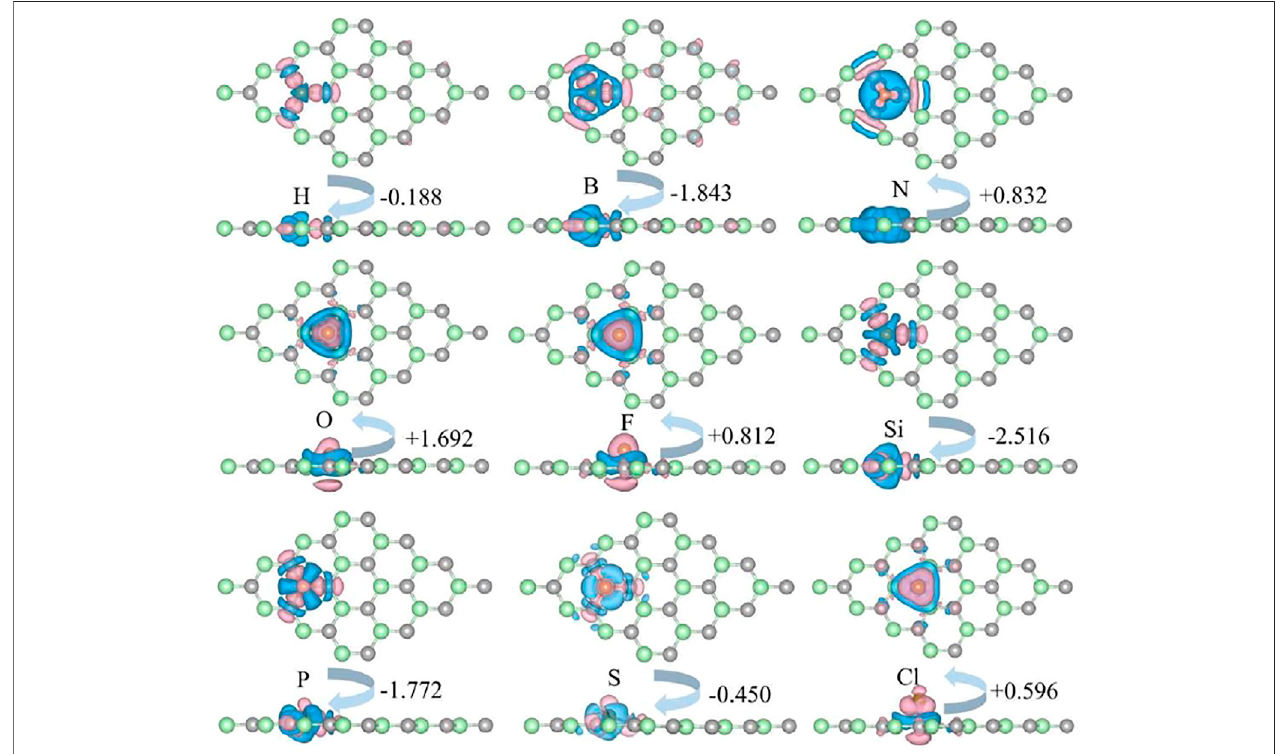
FIGURE4| ThechargedensitydifferenceoftheNM-SiCsystem.Theisovalueissetto0.001 e/Å 3 .Thepinkandtheblueregionsrepresentthegain,andthelossof the charge. The negative sign indicates the NM atoms act as charge donors, while the positive sign indicates the NM atoms act as charge acceptors.